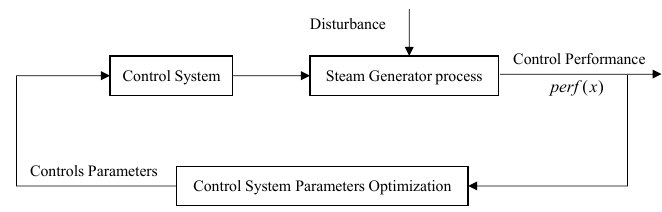
Figure 4. Structure of control system parameter optimization.